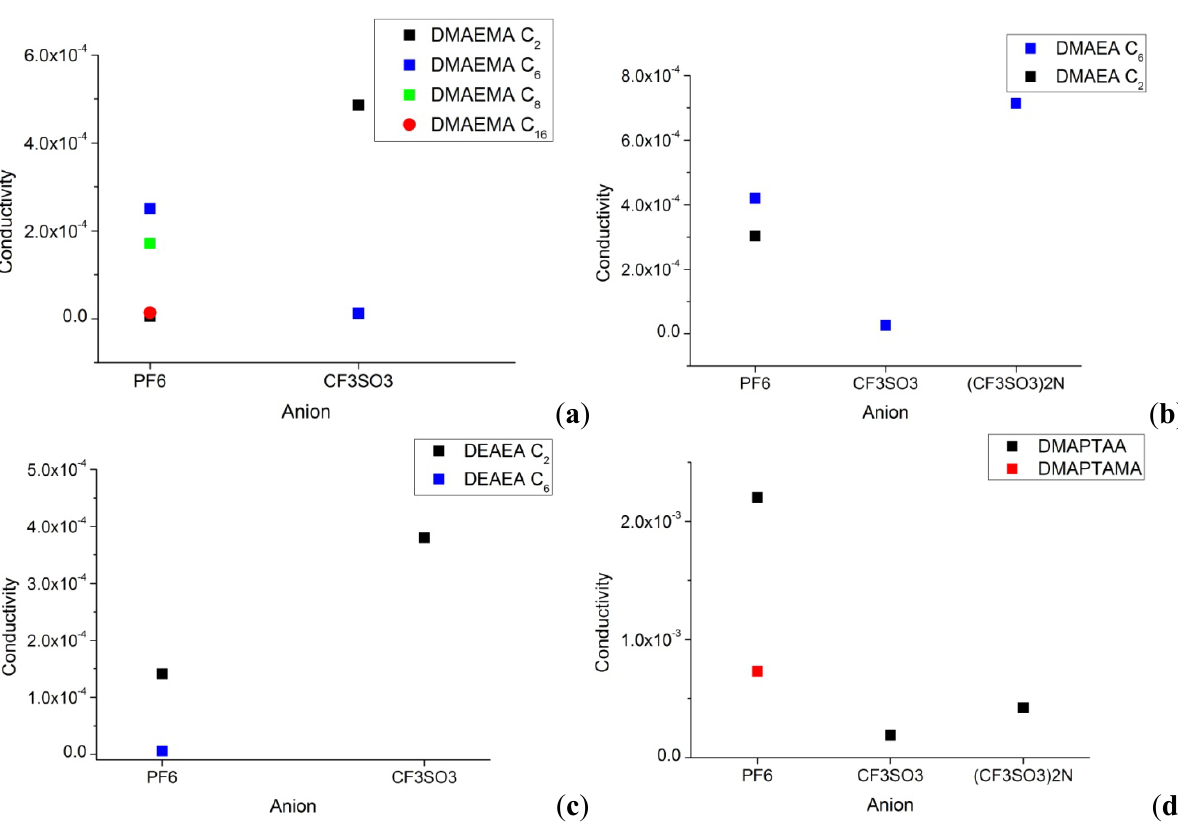
to C alkyl chain length. 2 16 and C alkyl chain 2 6